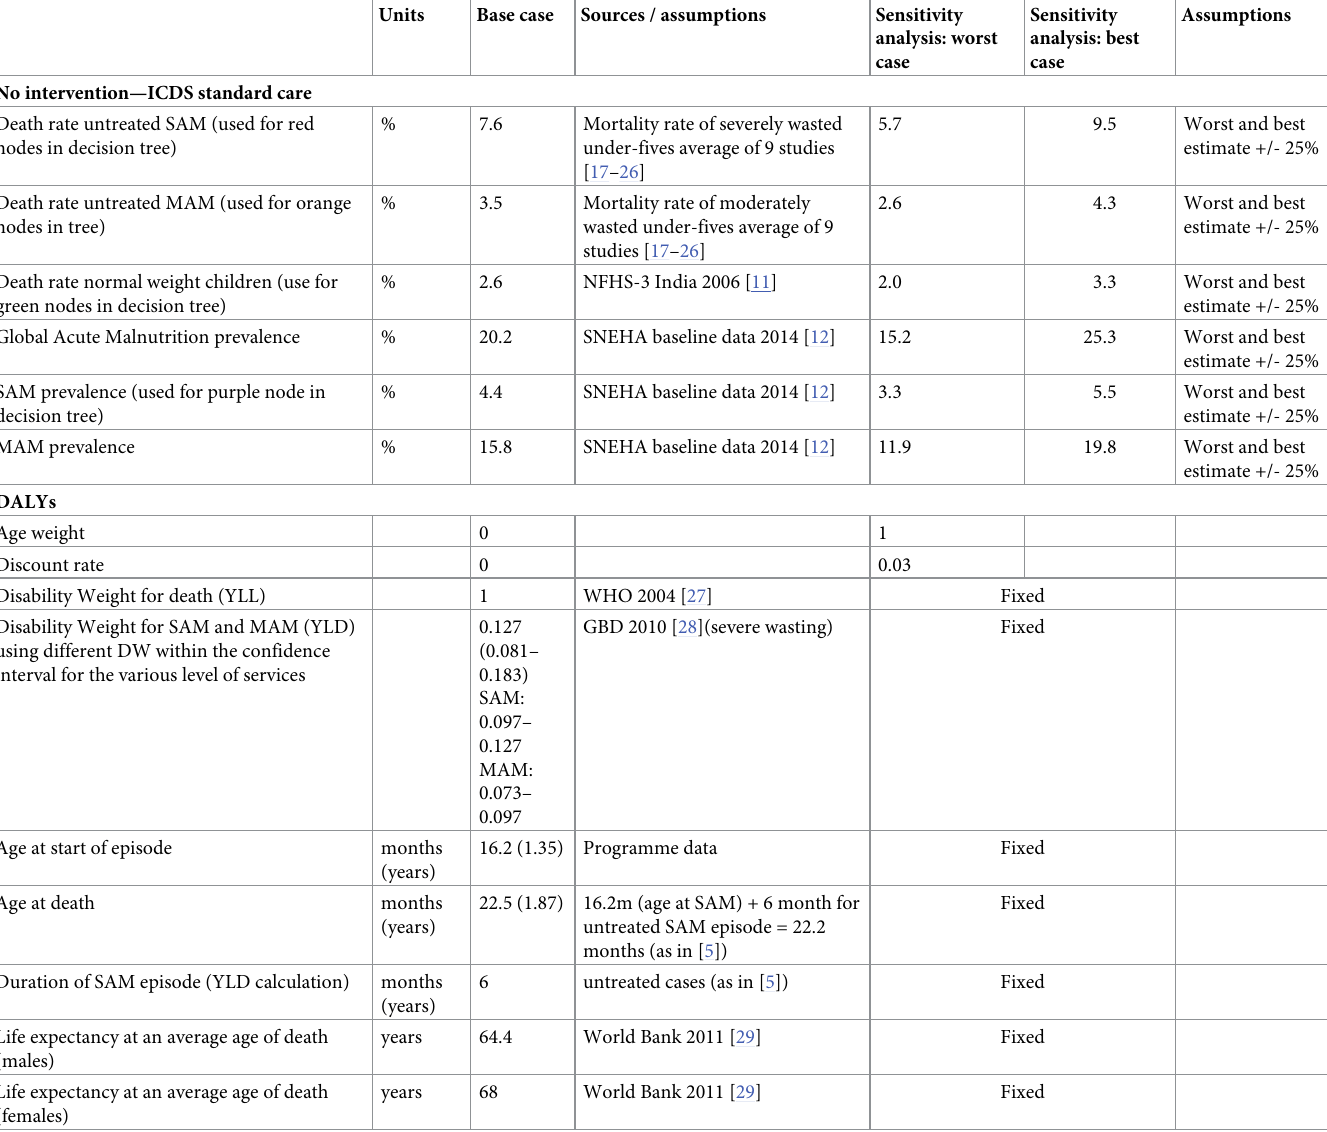
Table 2. Assumptions used to estimate Disability-Adjusted Life Years (DALYs) based on programme data and other evidence from previous CEA of nutrition